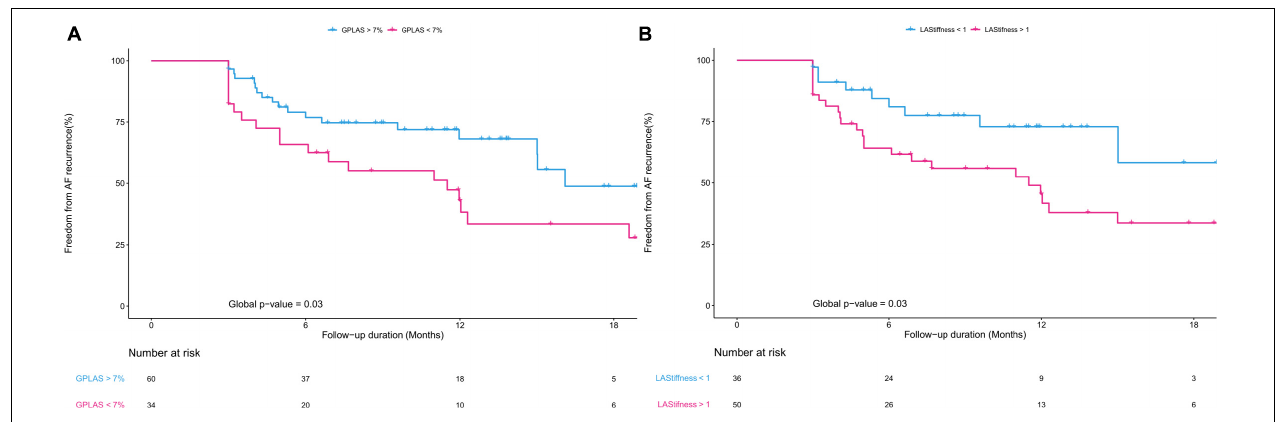
FIGURE 5 | Kaplan–Meier graphs showing freedom from AF recurrence after CA according to GPALS (A) and LA stiffness (B) .